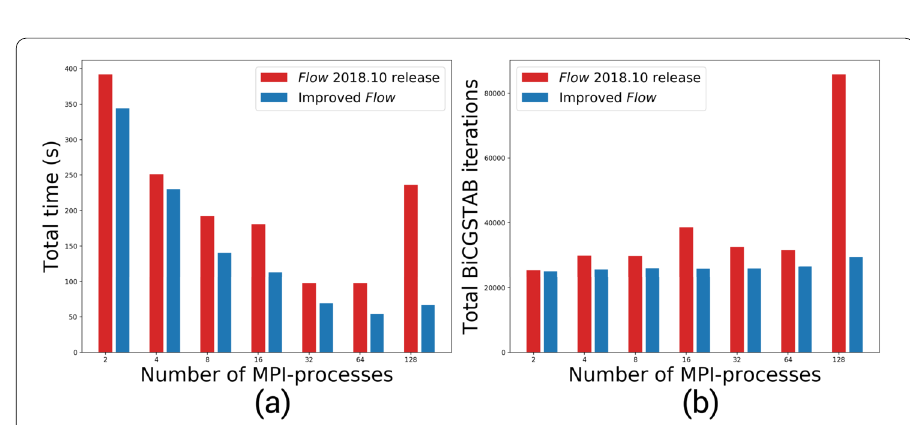
Figure 7 Overall execution time in seconds ( a ) and total number of BiCGStab iterations ( b ) of the 2018.10 release of Flow and our improved implementation, when applied to the Norne model. The simulations